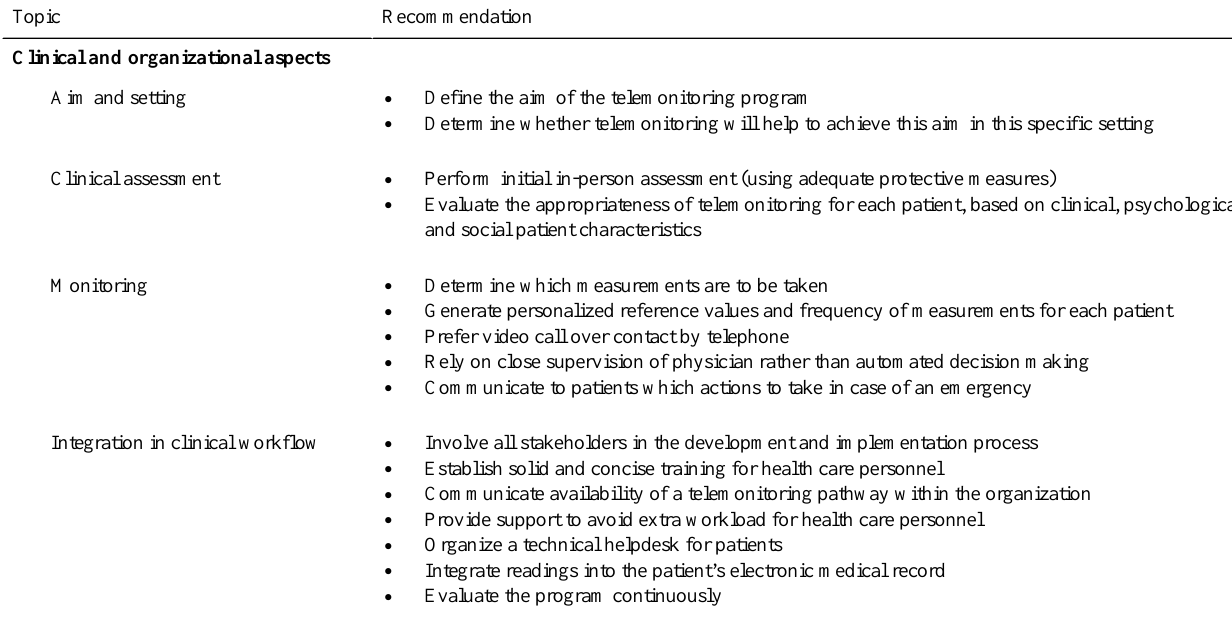
Table 1. Main recommendations to facilitate the implementation of a COVID-19 telemonitoring